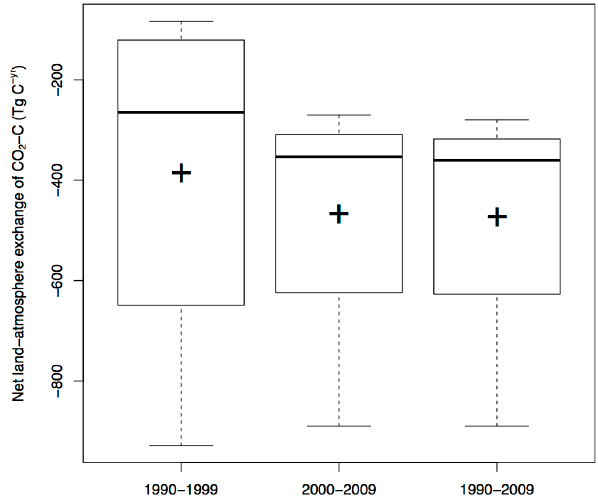
Figure 3. Box-and-whisker diagrams of the estimates from the dif- ferent methods. The bold horizontal line indicates the median, the + the mean. The upper and lower bounds of the box are the “hinges” of the Tukey box-and-whisker algorithm of R’s boxplot and approx- imate the interquartile range. The whiskers indicate the minimum and maximum